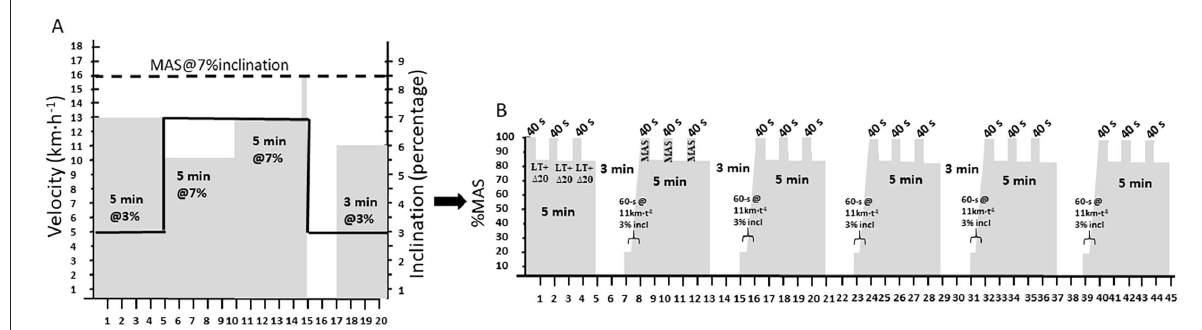
FIGURE1 (A) The standardised warm-up procedure was based on a gradual change in velocity (grey area) and inclination (solid black line) that was performed prior to all high-intensity interval (HIT) sessions. (B) The HIT sessions consisted of 6 x 5-min varied-intensity work intervals. Each 5-min work interval started with 40s at maximal aerobic speed (MAS) followed by 60s at the speed equal to lactate threshold (LT) + 20% of the difference between LT and MAS. This 100-s module was then repeated three times in each 5-min work